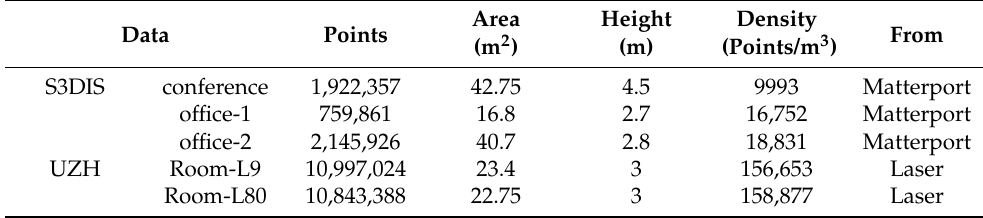
Table 1. Descriptions of the